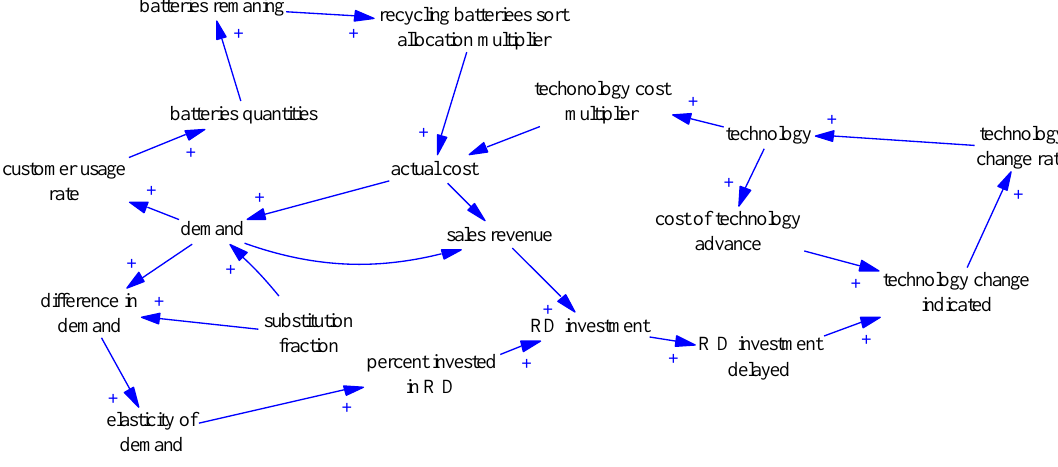
Figure 2. Cause and effect diagram.